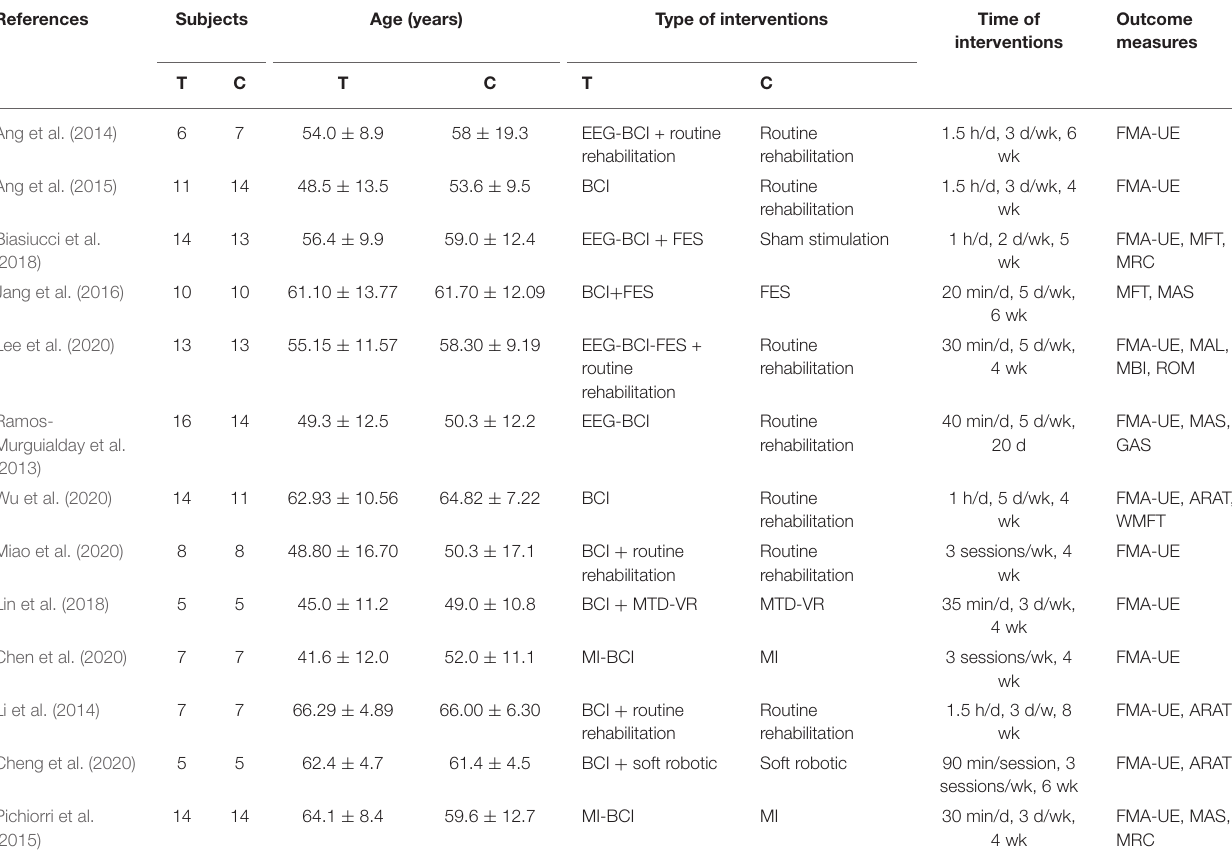
TABLE 1 | Characteristics of the RCTs.